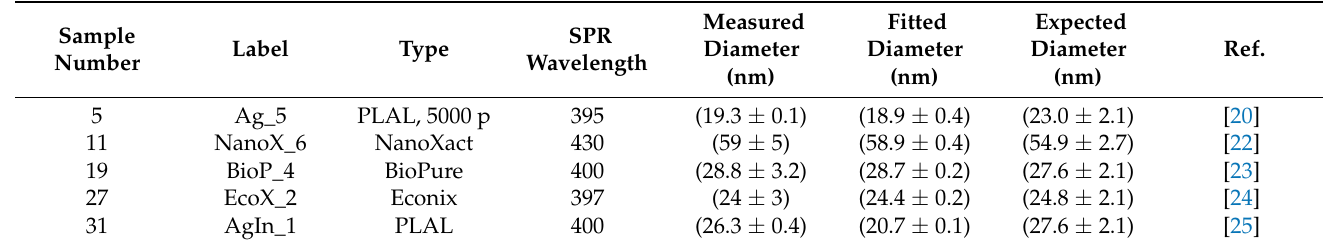
Table 1. List of labels, types, SPR wavelengths, measured, fitted, and expected diameters of represen- tative colloidal silver nanoparticles selected from each sample group with references.